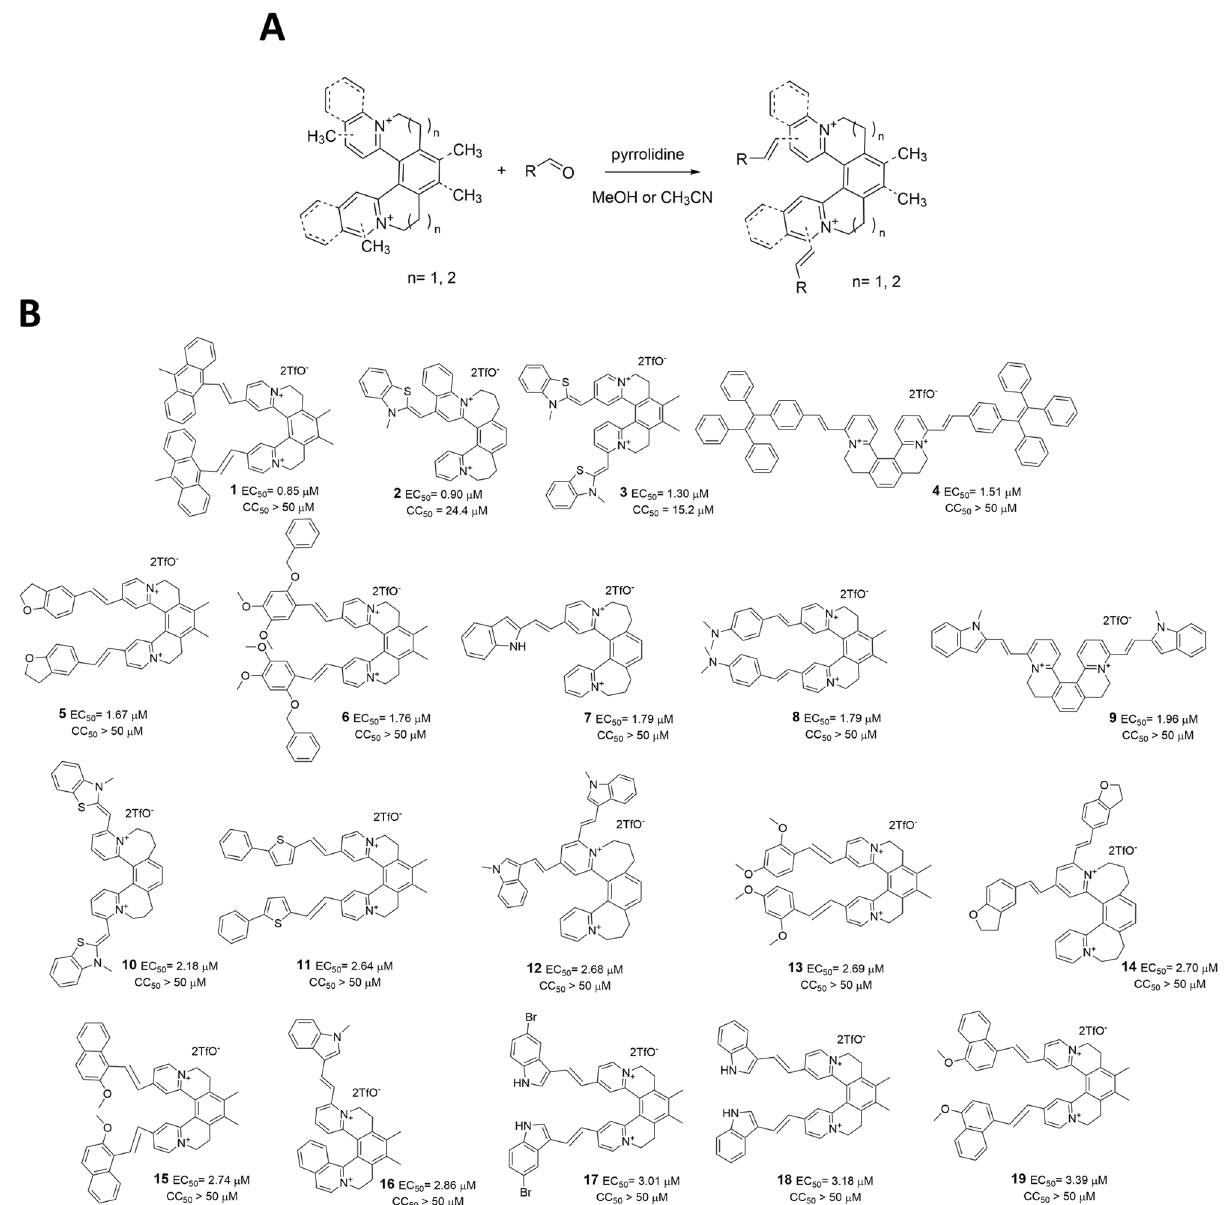
Figure 2. ( A ) Synthesis of substituted helquats using a Knoevenagel condensation. ( B ) Structures and EC 50 and CC 50 values of selected helquat compounds in cytopathic effect-based assay using MT-4 cells infected by HIV-1 (NL4-3